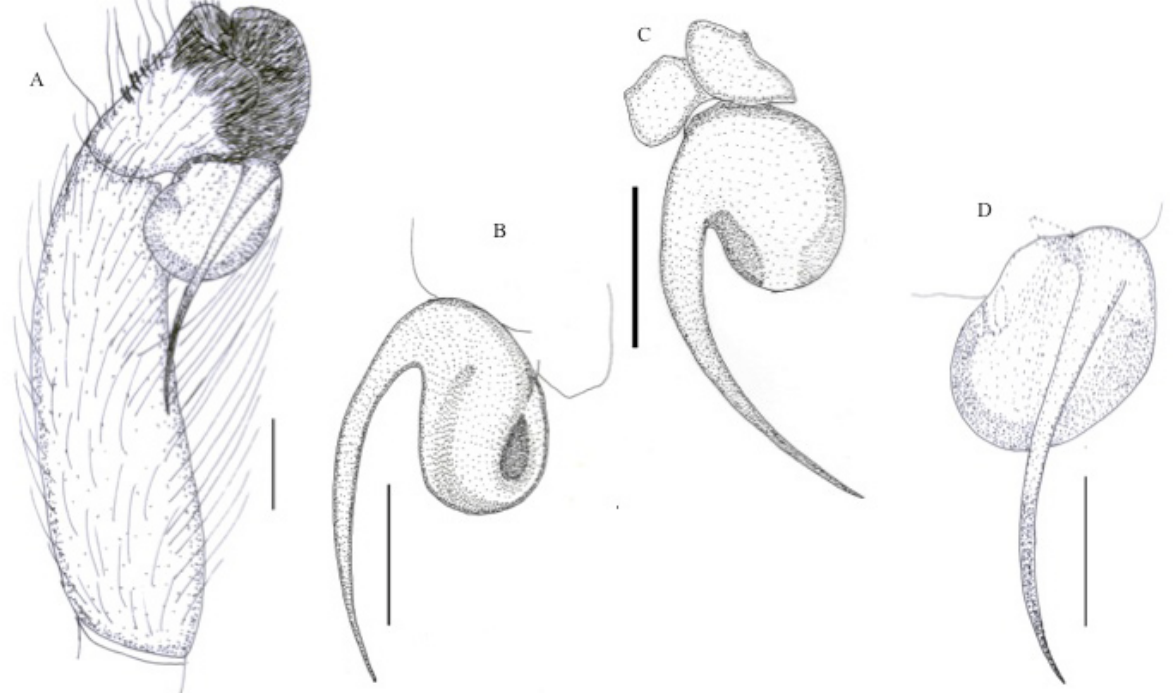
Figure 3. Neoheterophrictus crurofulvus sp. nov., male (WILD-09-ARA-472). A - Tibia to Palp, retrolateral view; B - Palp, Prolateral view; C - Palp, retroventral view; D - Palp, retrolateral view. Scale 1.0mm for